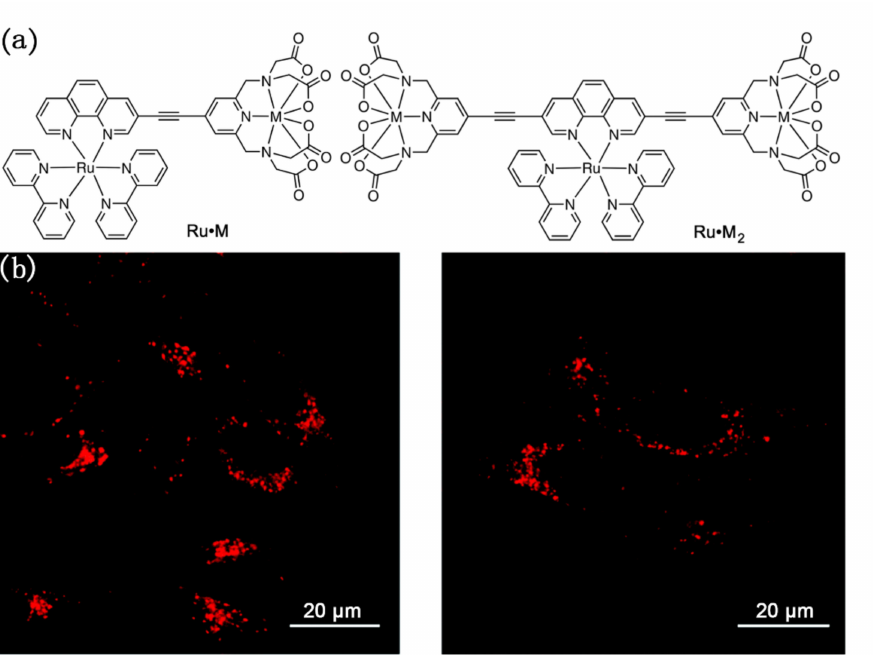
Figure 18. ( a ) The structure of Ru · M and Ru · M 2 ; ( b ) Confocal microscopy images of HeLa cells incubated with Ru · Gd (left) or Ru · Gd 2 (right). Scale bars = 20 µ m. Reprinted with permission from [92]. Copyright 2019, Royal Society of